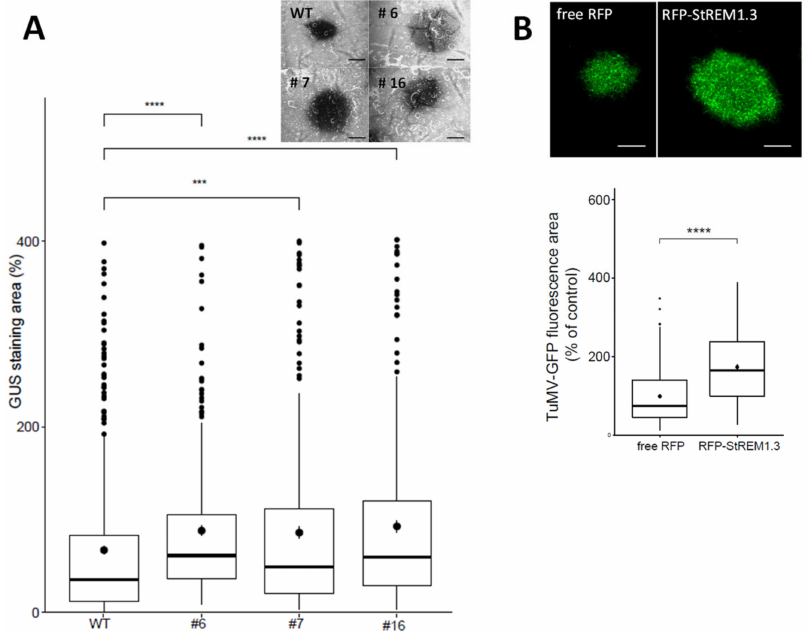
Figure 1. Stable and transient over-expression of StREM1.3 favour TuMV spreading in N. benthamiana : ( A ) effect of StREM1.3 overexpression in three independent stable transgenic N. benthamiana lines. The area of infection foci is normalised and expressed in % of the area of TuMV propagation in wild-type (WT) plants. Beta-glucuronidase tagging (GUS) of TuMV allowed the observation and measurement of infection surface foci induced by TuMV in the GFP–StREM1.3-overexpressing lines. At least 200 infection foci from at least 4 independent experimental repeats were imaged at 5 days post-inoculation (dpi). Statistical analysis was performed using one-way ANOVA, followed by Student’s t -test in R software (ANOVA, p = 0.0024; **** < 0.001, ***: 0.001). Scale bar: 500 µ m; ( B ) effect of transient overexpression of RFP–StREM1.3. The area of infection foci is normalised and expressed in % of the area of virus propagation in the absence of REM (free RFP negative control). Statistical analysis was performed using one-way ANOVA, followed by Student’s t -test (ANOVA, p < 2.2 × 10 − 16 ; **** < 0.001). At least 200 infection foci from at least 4 independent repeats were imaged at 5 days post-inoculation (dpi). Scale bar: 500 µ